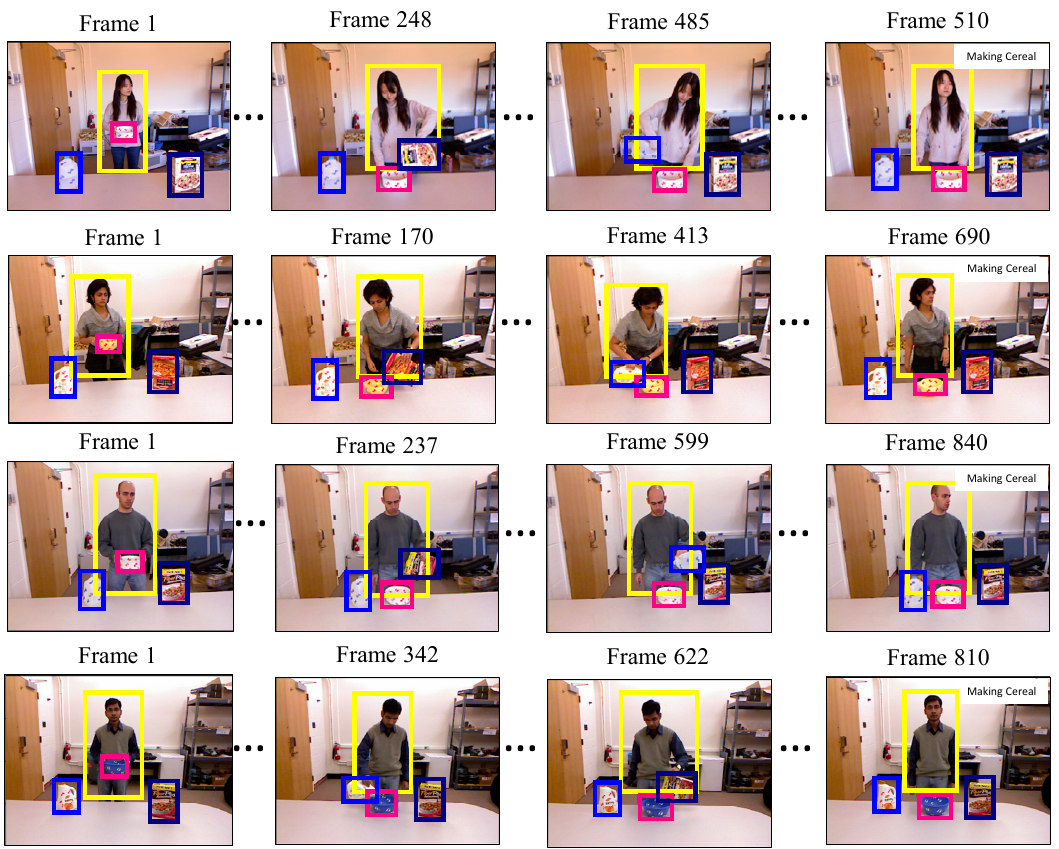
The percentage of correctly recognized actions in the CAD-120 dataset are highlighted in yellow color.